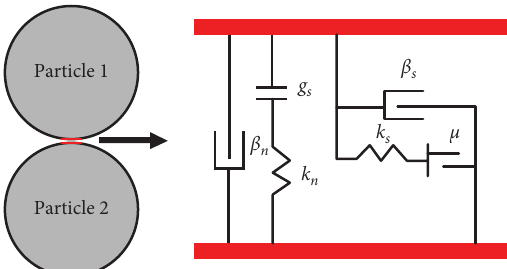
Figure 2: Behavior and rheological components of the linear model